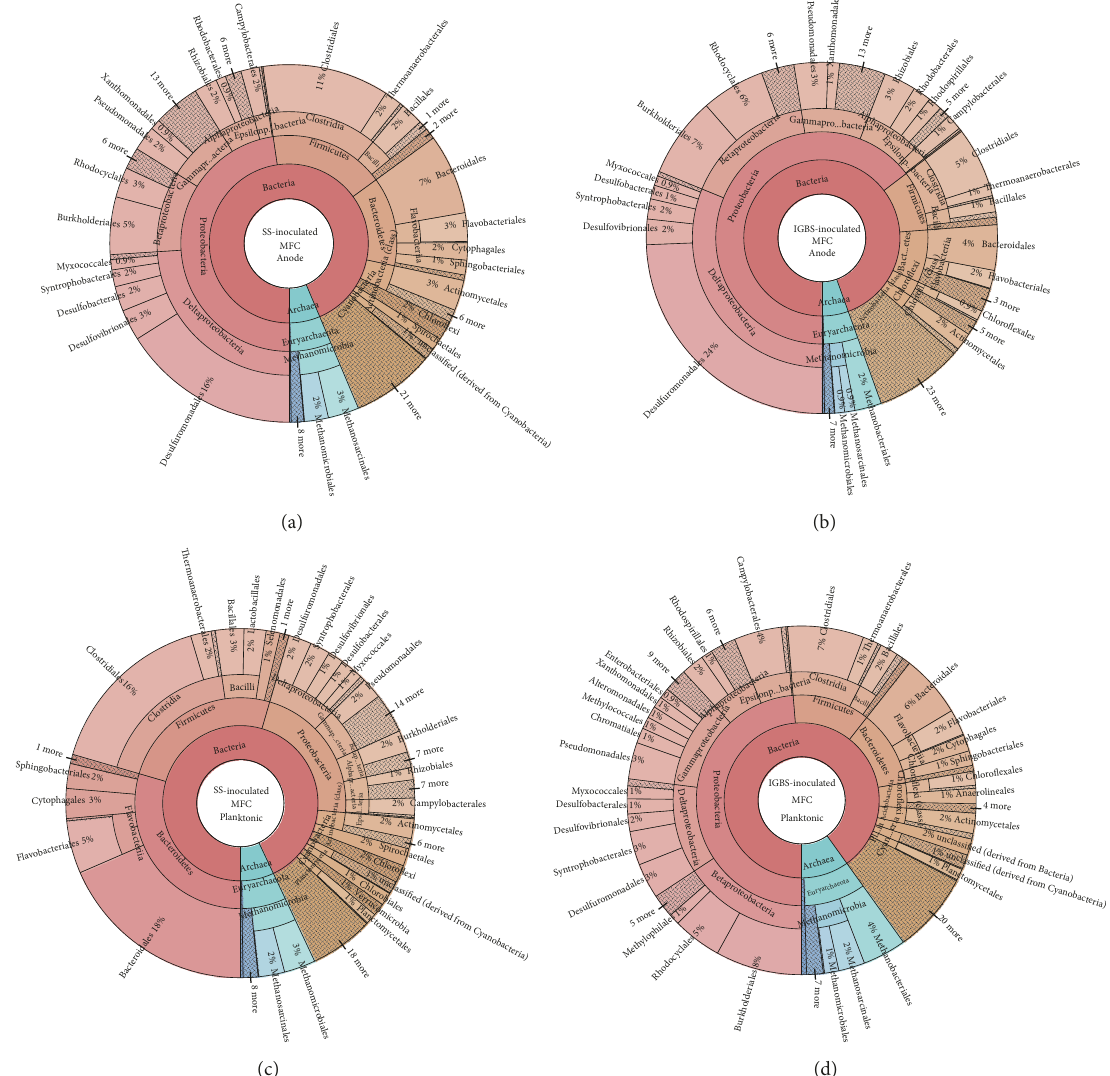
Figure 2: Summary of the anodic and planktonic microbial community profiles in multilevel Krona diagrams. Krona plots visualizing taxonomic hierarchies of the microbial communities of (a) swine sludge-inoculated MFC anode, (b) industrial granular brewery sludge- inoculated MFC anode, and (c) swine sludge-inoculated MFC planktonic contents, and (d) industrial granular brewery sludge-inoculated MFC planktonic